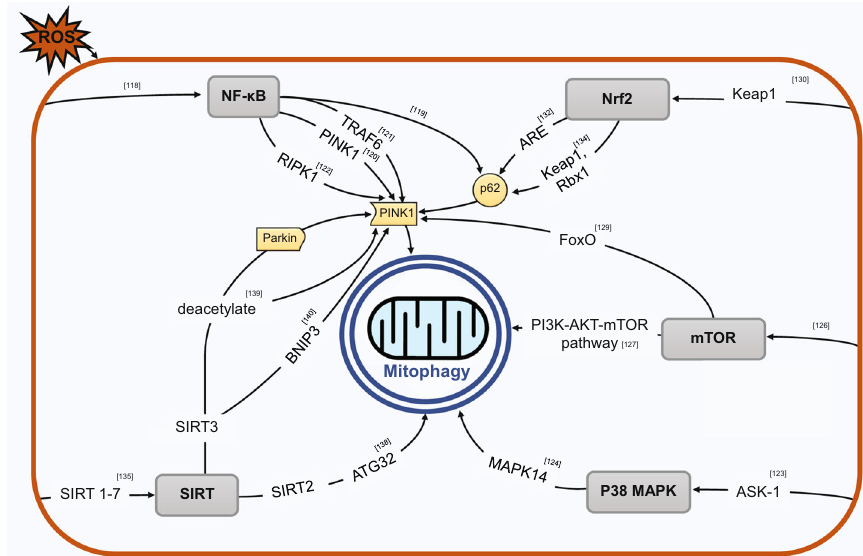
Fig. 2 Core signalling pathways bridging ROS and Mitophagy. ROS function upstream of intracellular signalling pathways which involve several key mediators (NF- κ B, p38 MAPK, mTOR, Nrf2, SIRT) to regulate